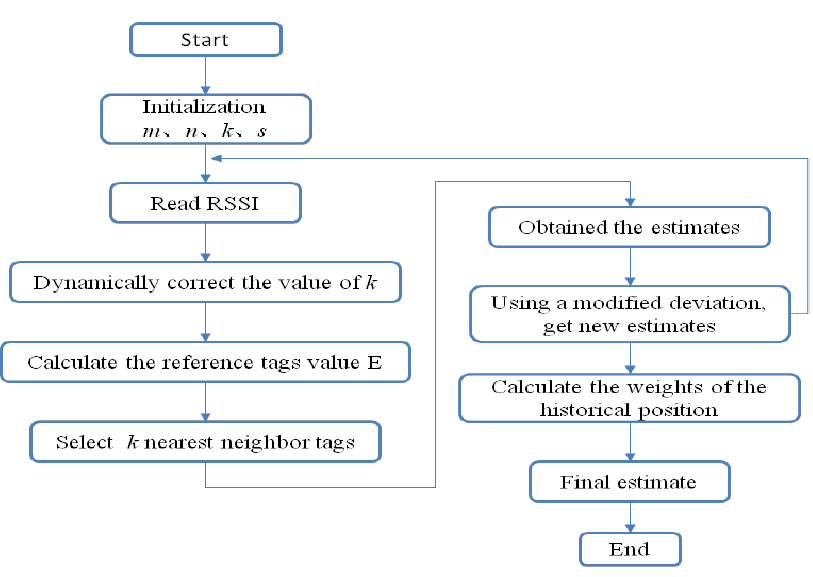
Figure 5. The localization algorithm